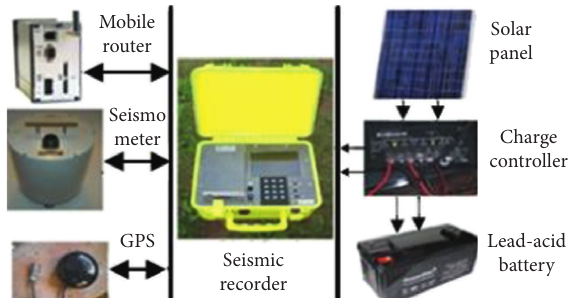
Figure 1: The layout of energy harvesting system powering Nsukka seismic